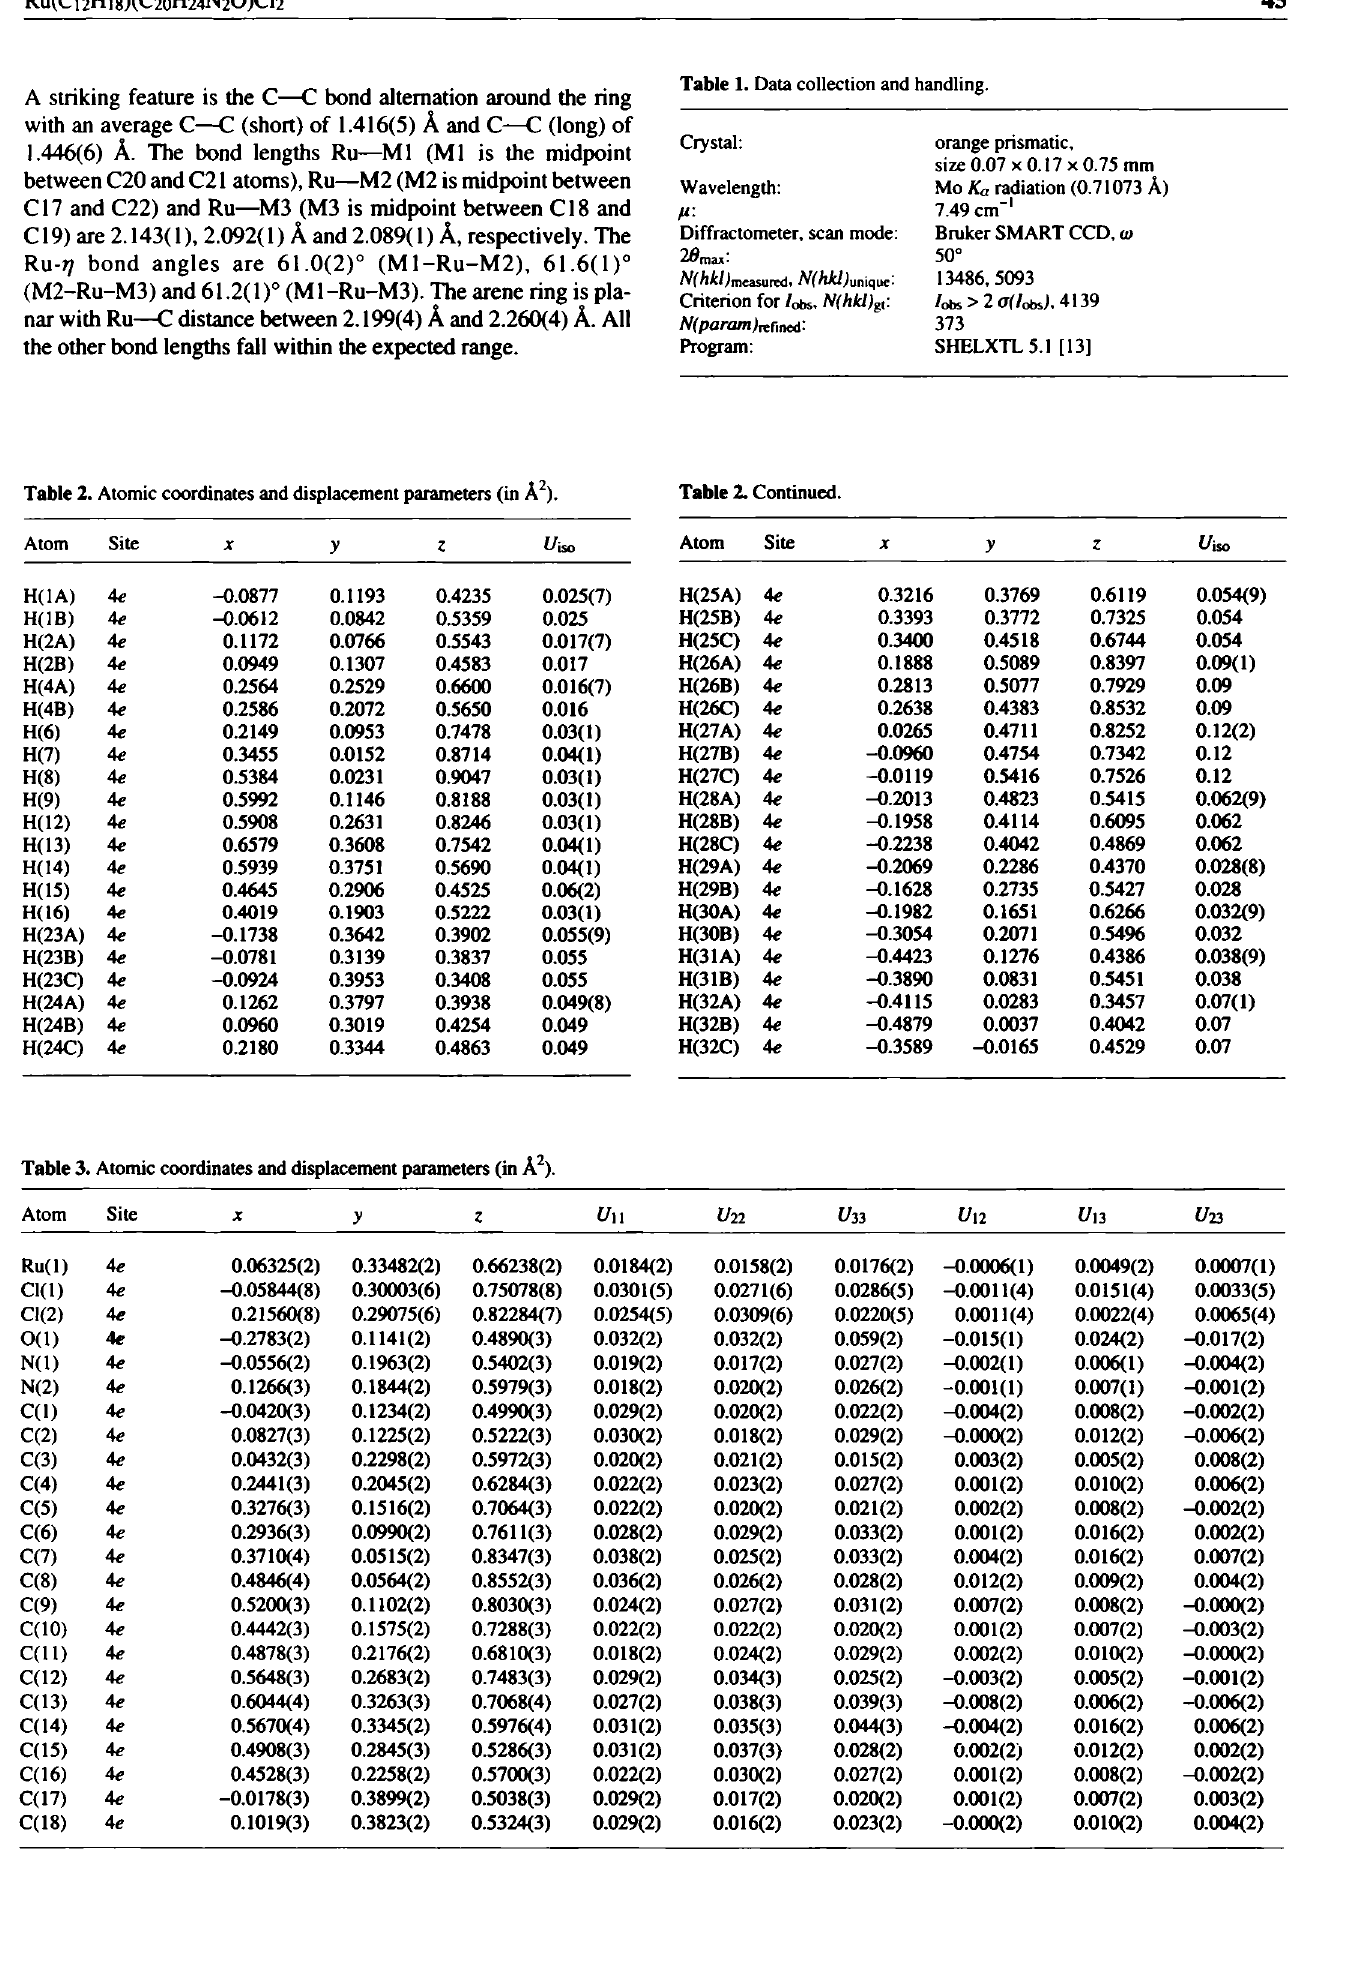
Table 2. Atomic coordinates and displacement parameters (in A 2 ).